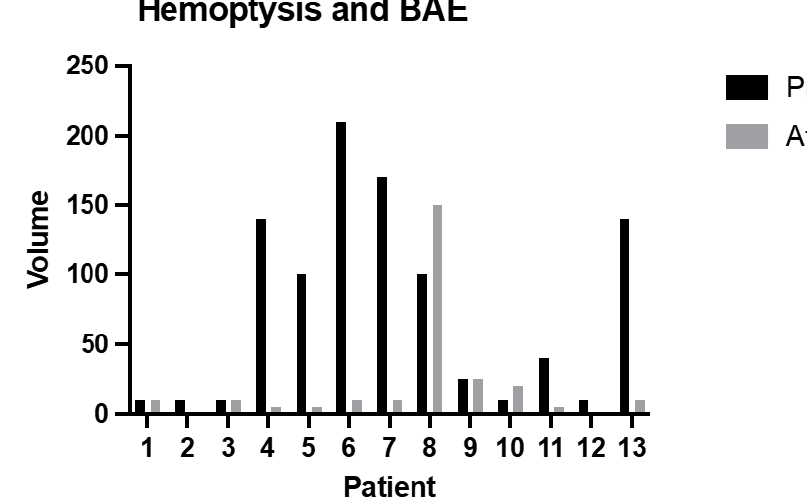
Figure 4. The amount of blood sputum (mL) before treatment and during the relapse episode (after treatment) ( p = 0.0466).